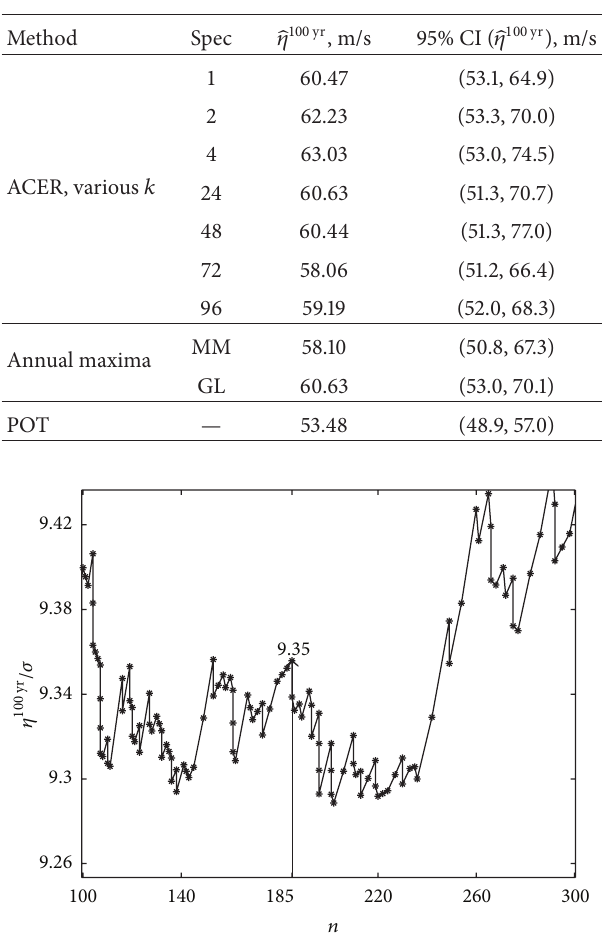
Table 3: Predicted 100-year return period levels for Nordøyan Fyr weather station by the ACER method for different degrees of conditioning, annual maxima, and POT methods, respectively.